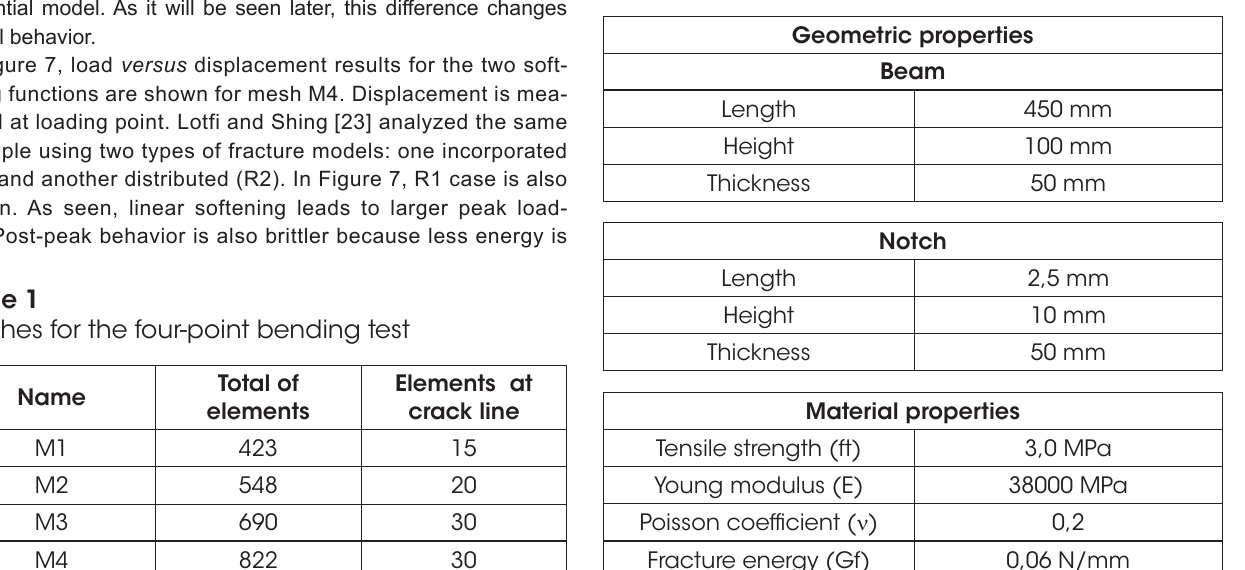
Input parameters for the four-point bending